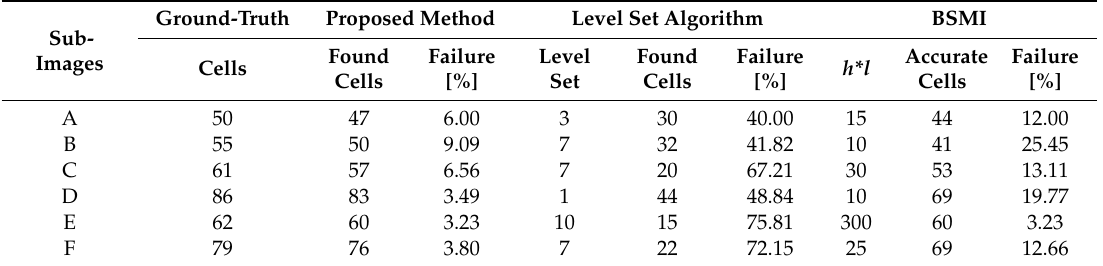
Table 6. Results obtained with the meristem segmentation